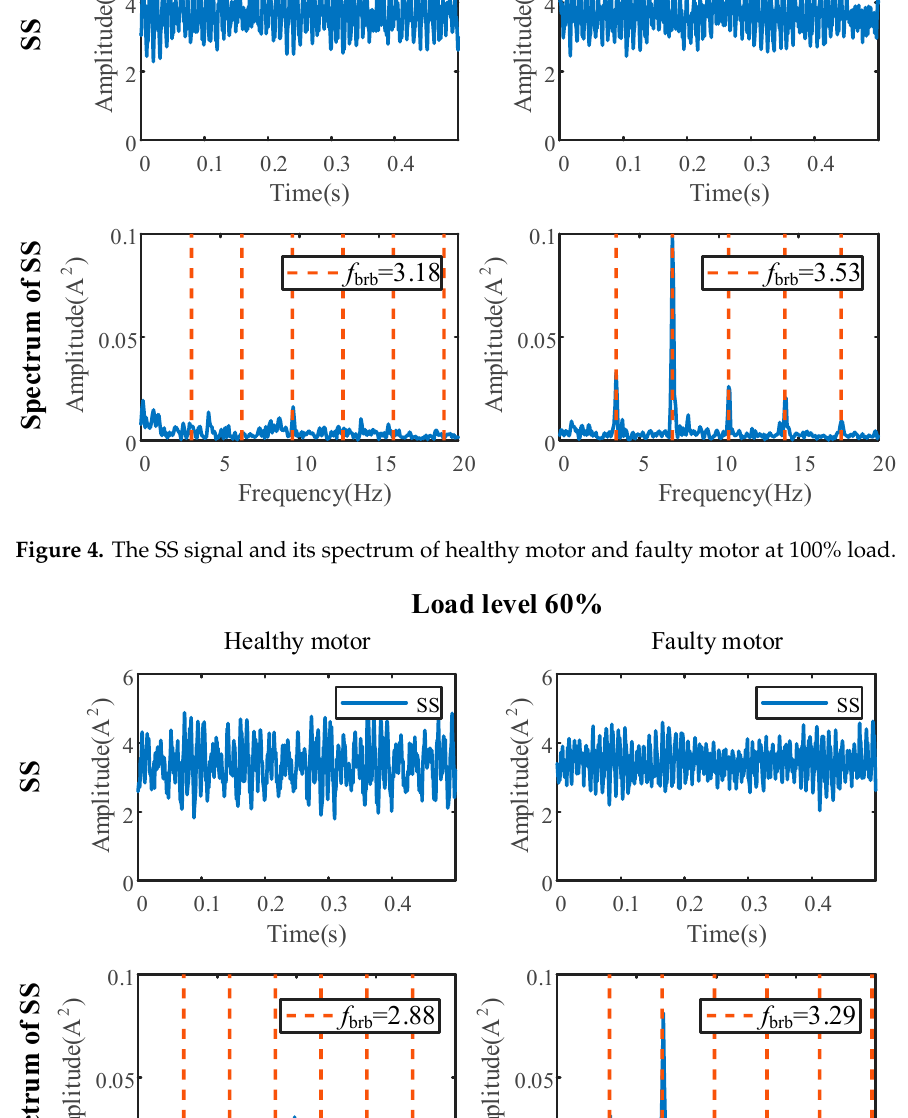
Figure 6. The SS signal and its spectrum of healthy motor and faulty motor at 20% load. Finally, the SS method is used to analyze the experimental data of the IMs under different motor rotation speeds. The experimental data are obtained when the motor supply frequency is 30.5 Hz, 40 Hz, and 48.5 Hz and the load level is 100%. The result of the SS method is shown in Figure 7. It can be seen that the slip of the motor gradually decreases as the rotation speed increases, and the signature frequency components are always obvious. This demonstrates that the SS method is also effective under different rotation speeds.